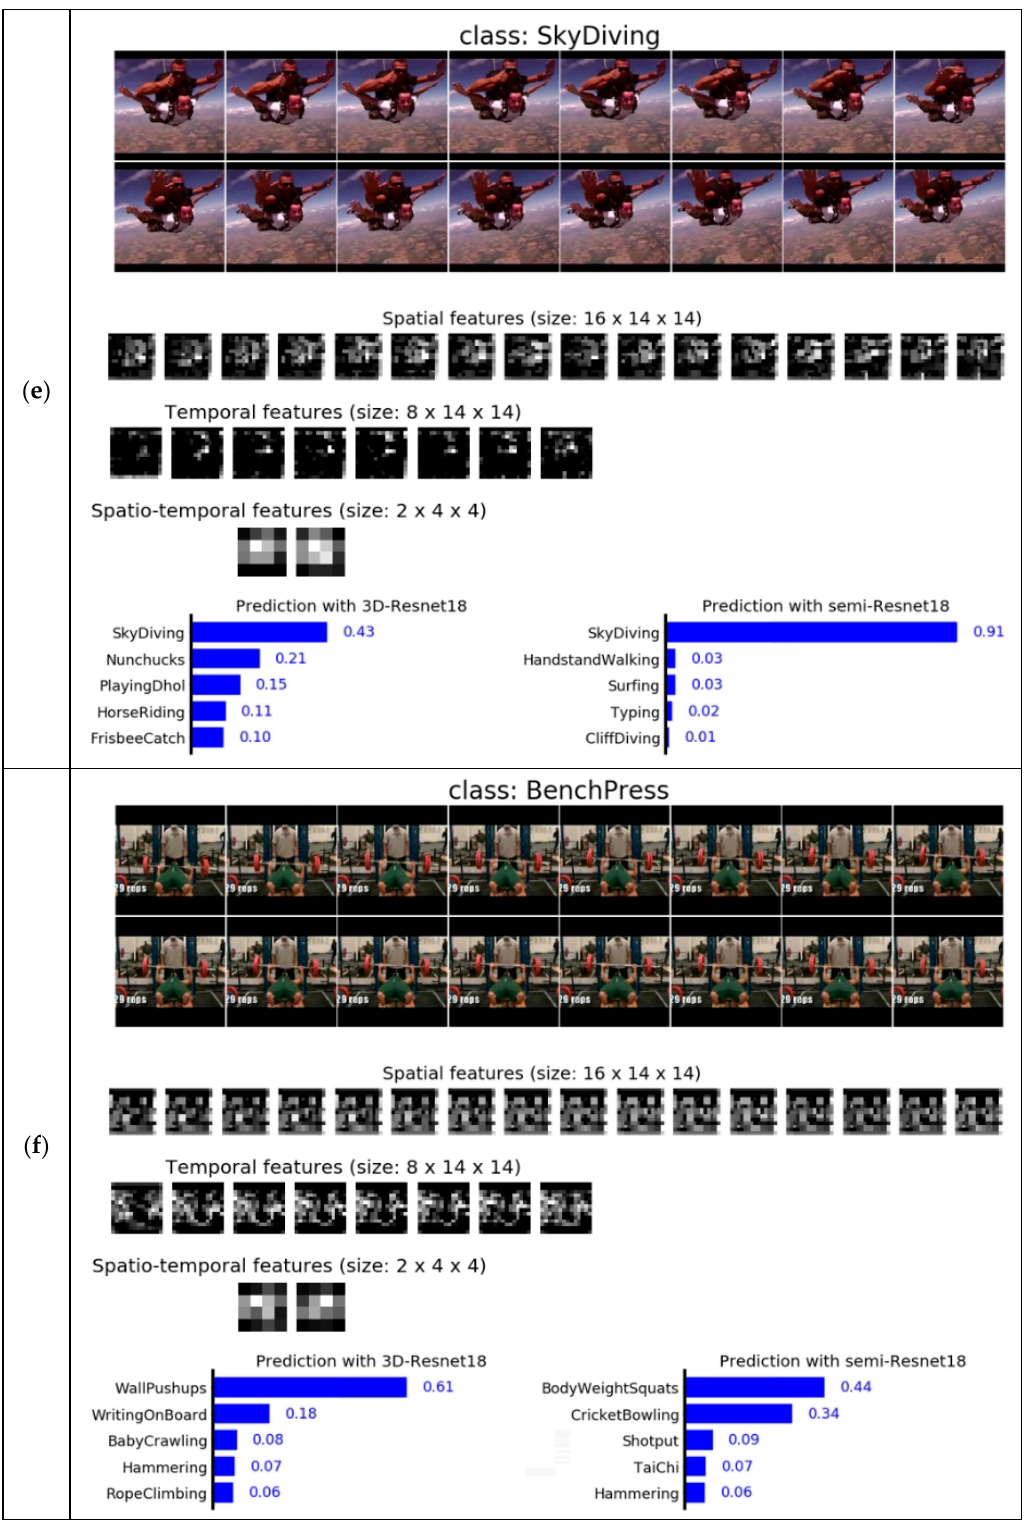
Figure 3. Examples of qualitative results for 3D- and Semi-ResNet-18 for different action classes: ( a ) hammer throw, ( b ) Still rings, ( c ) Military parade, ( d ) Wall pushups, ( e ) Sky diving, and ( f ) Bench press.